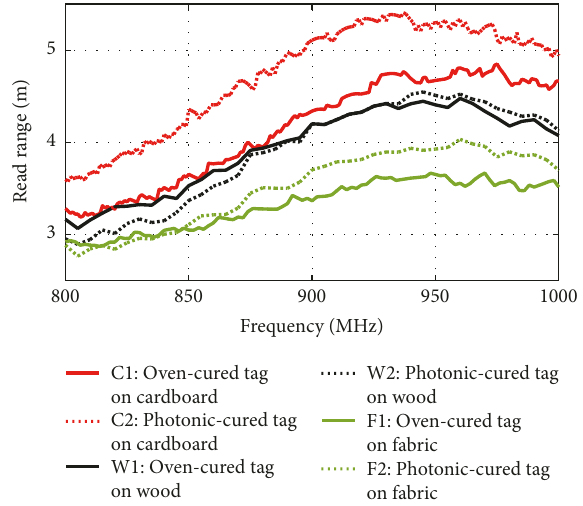
Figure 9: Read range values of oven- and photonic-cured graphene tags on cardboard (C1, C2), wood (W1, W2), and fabric (F1,